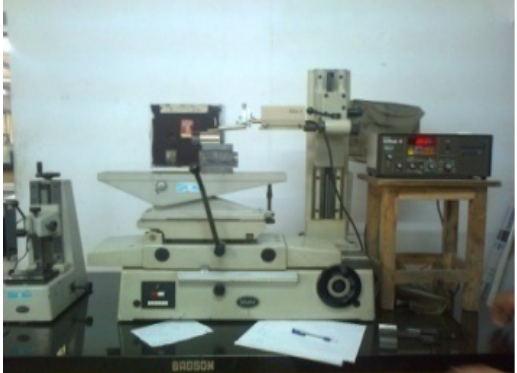
Fig. 4. Mitutoyo surftest-4 surface roughness